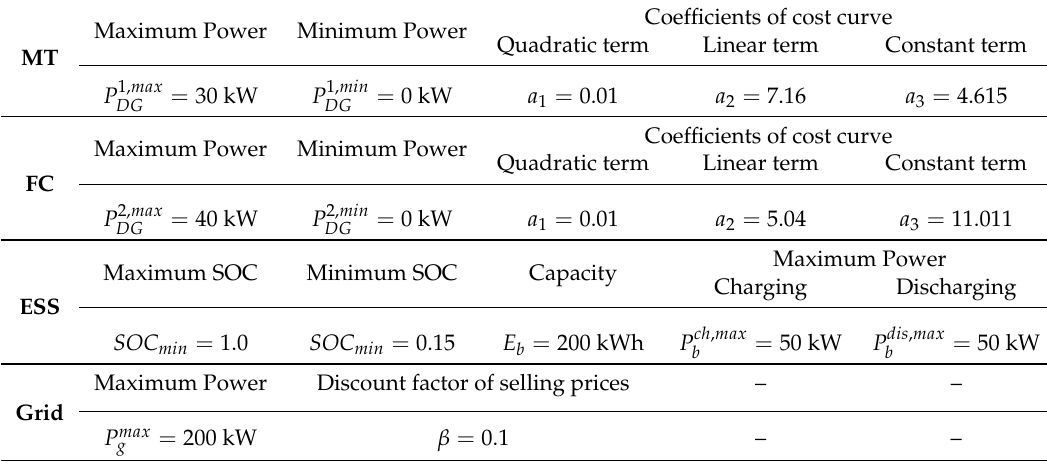
Table 1. Technical constraints and operation parameters of the MG generators and the main